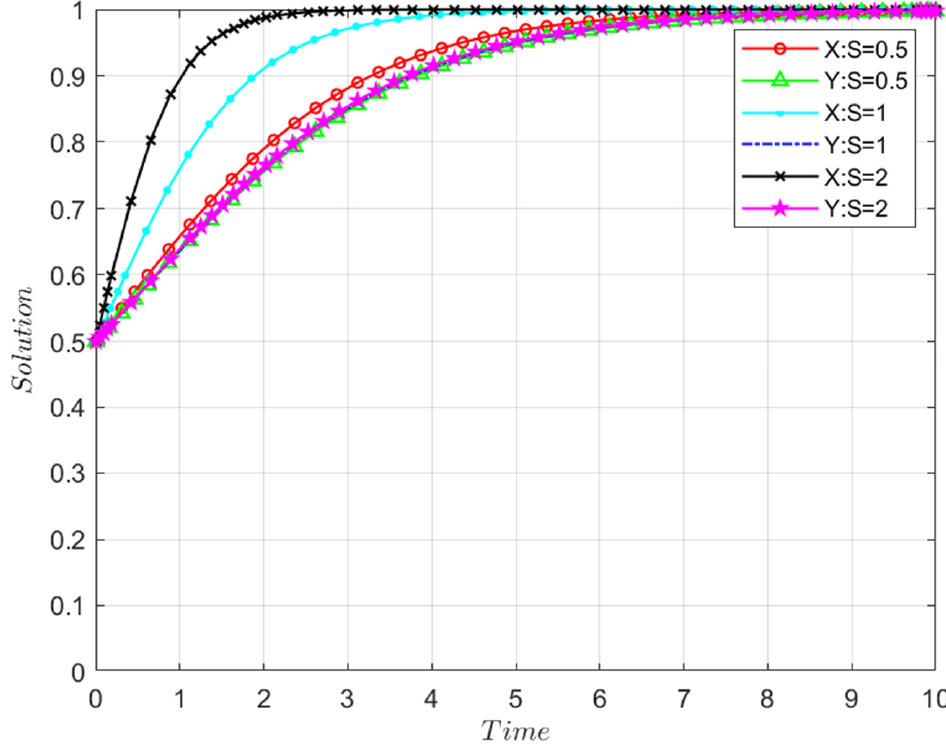
Figure 3. Trend of the farmer–enterprise evolutionary game strategy under government interven- tions.